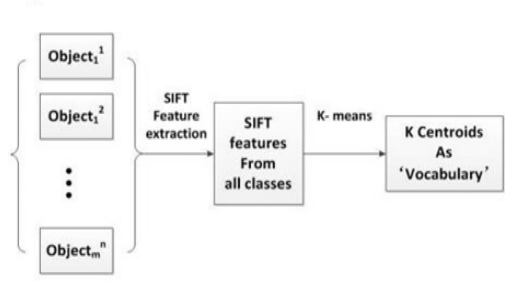
Figure 5. The process about creating vocabularies. Objects are sample images from different classes in the train set. And in each class, there may contain several samples.